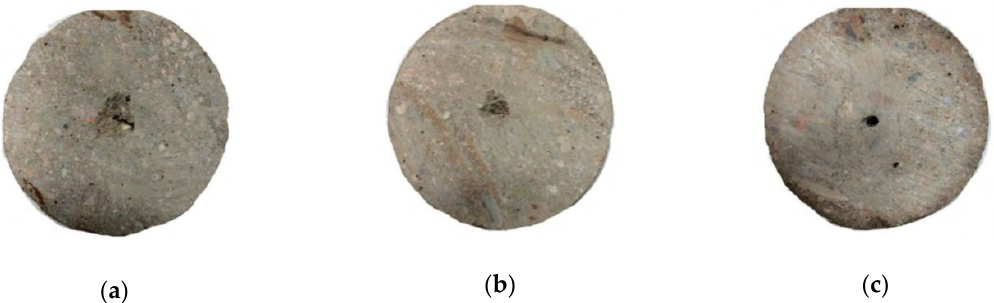
Figure 1. Rock breakage effect: ( a ) the swirling SC-CO 2 jet; ( b ) the swirling-round SC-CO 2 jet; ( c ) the round SC-CO 2 jet.